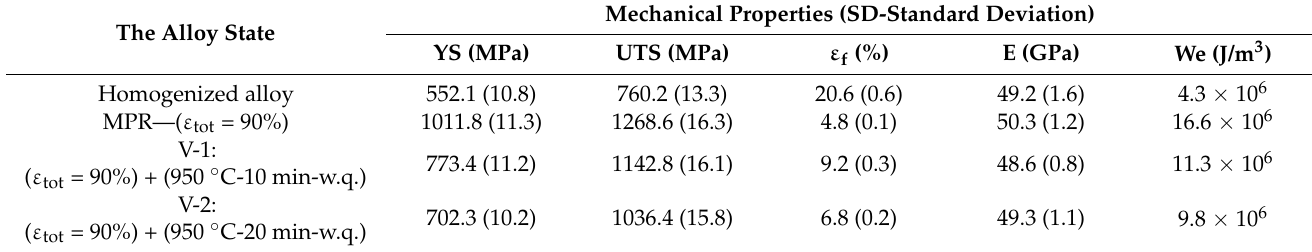
Figure 8. The stress-strain curves of the samples processed by SPD and ST compared to the initial homogenized state. Table 1. Mechanical properties of the studied alloy: ultimate tensile strength (UTS); yield strength (YS); elongation to fracture ( ε f ); elastic modulus (E); elastic energy (We); SD (standard